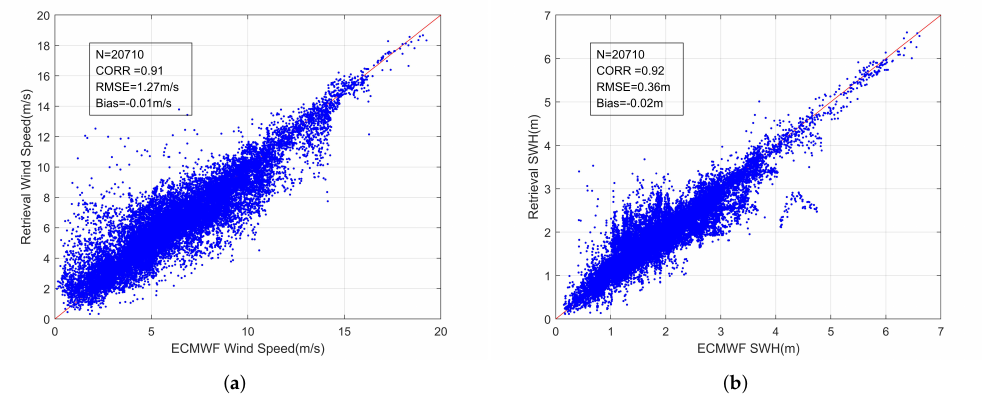
Figure 9. Joint retrieval results compared with ECMWF reanalysis data. ( a ) wind speed; ( b ) SWH. The red line represents the reference line ’y = x’.